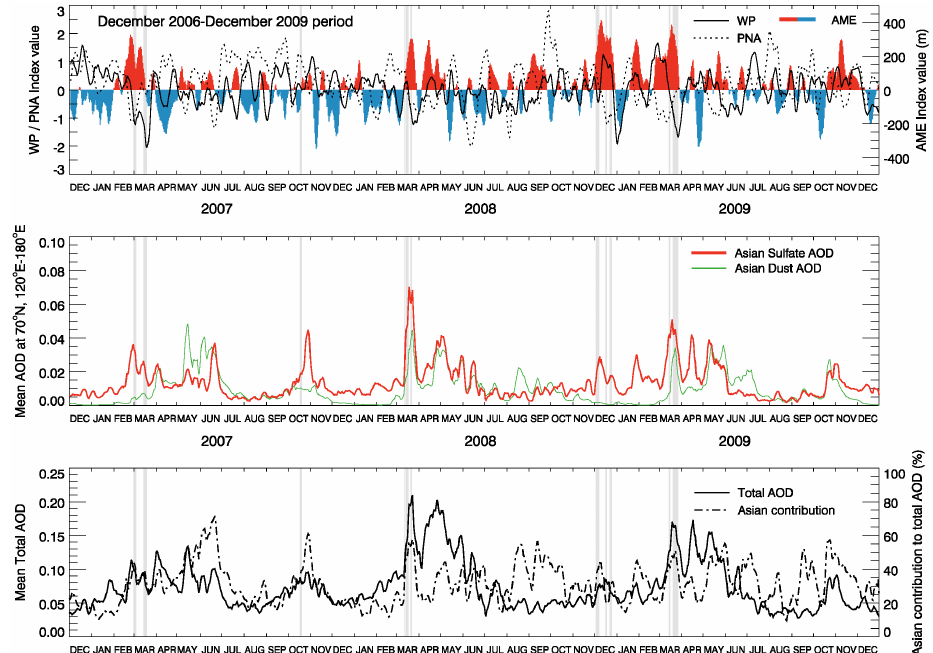
Figure 13. Time series of meteorological indices and Asian AOD for December 2006-December 2009. Top panel: WP, PNA, and AME (red=positive, blue=negative) indices. The WP index is based on Wallace and Gutzler (1981) and the PNA index is obtained from http://www.cpc.noaa.gov/products/precip/CWlink/daily_ao_index/history/history.shtml. See text for the definition of the AME index. A two-day lag is applied to all indices. Middle panel: Asian Sulfate and Asian Dust AOD calculated by GEOS-Chem at 70ºN averaged between 120ºE and 180ºE. Bottom panel: Total AOD at 70ºN averaged between 120ºE and 180ºE and percentage contributed by Asia. All timeseries are smoothed with a 7-day running mean. The vertical grey bars show the 11 instances when CALIOP intercepted Asian plumes over the Arctic.